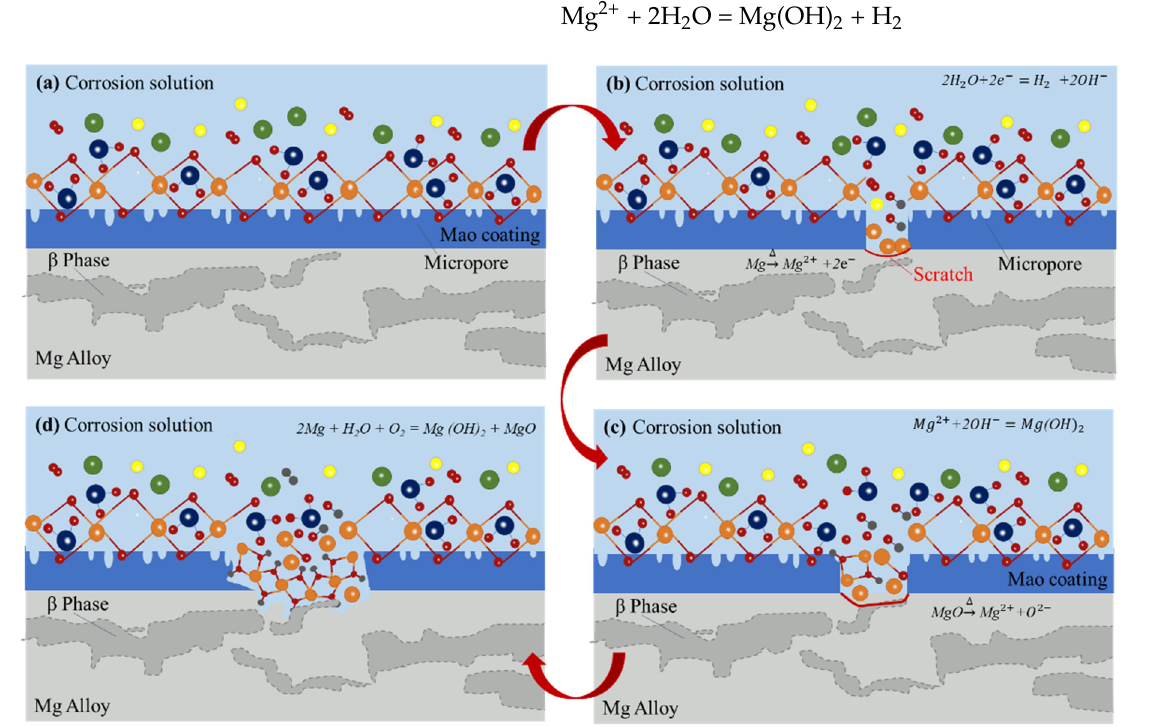
Figure 13. Local corrosion process model of coatings. ( a ) The sample coated with a complete coating is placed in a corrosive solution; ( b ) The coating is scratched by uncontrollable factors such as external mechanical forces; ( c ) The magnesium alloy substrate begins to oxidize when contacting with the corrosion solution, and the coating loses its support, leading to cracking; ( d ) The local corrosion at the coating defect gradually expands to form corrosion pits,